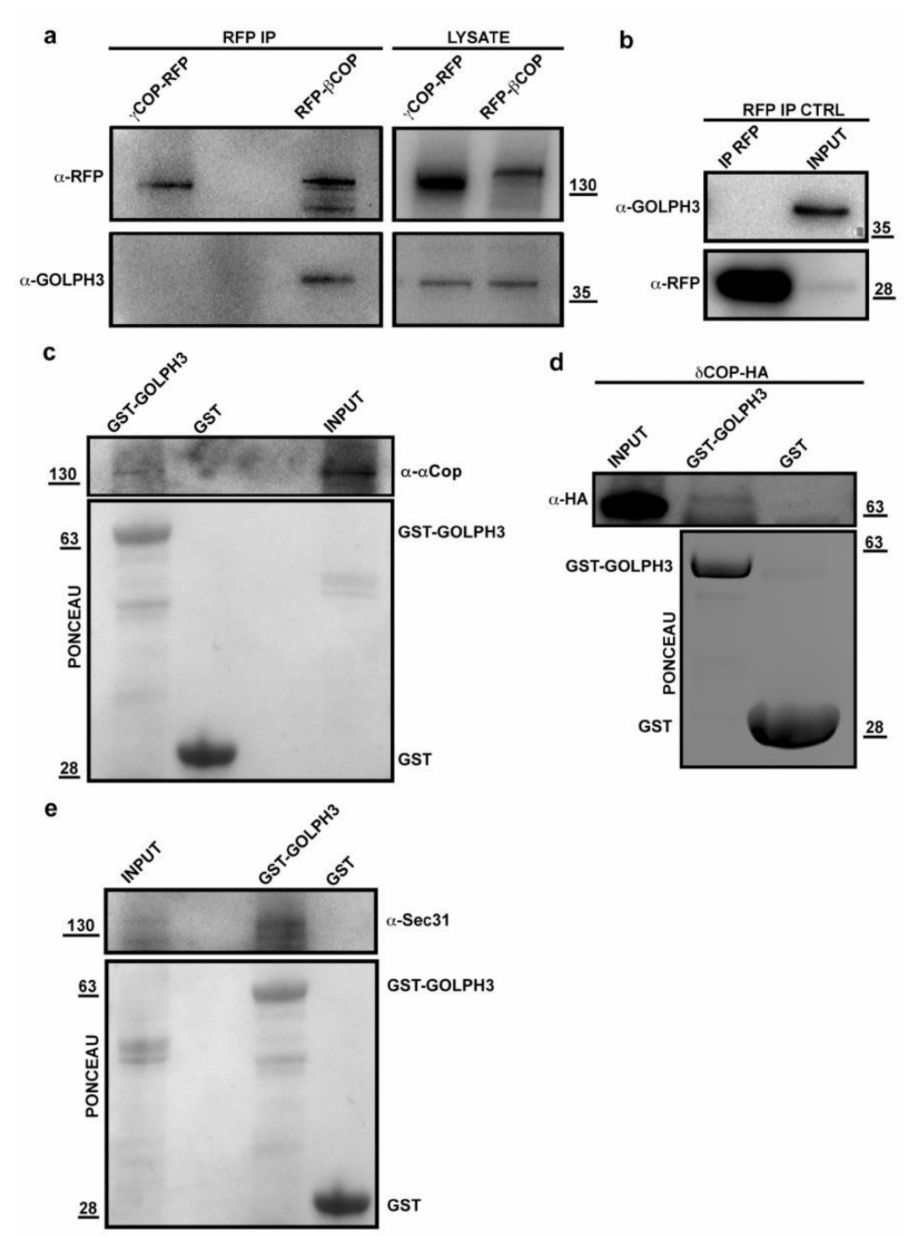
Figure 3. dGOLPH3 interacts with COPI subunits and Sec31 protein. ( a , b ) dGOLPH3 protein coprecipitated with RFP– β COP but not with γ COP-RFP and RFP. Protein extracts from testes ex- pressing RFP– β COP, γ COP-RFP ( a ) and RFP (RFP IP CTRL) ( b ), were immunoprecipitated